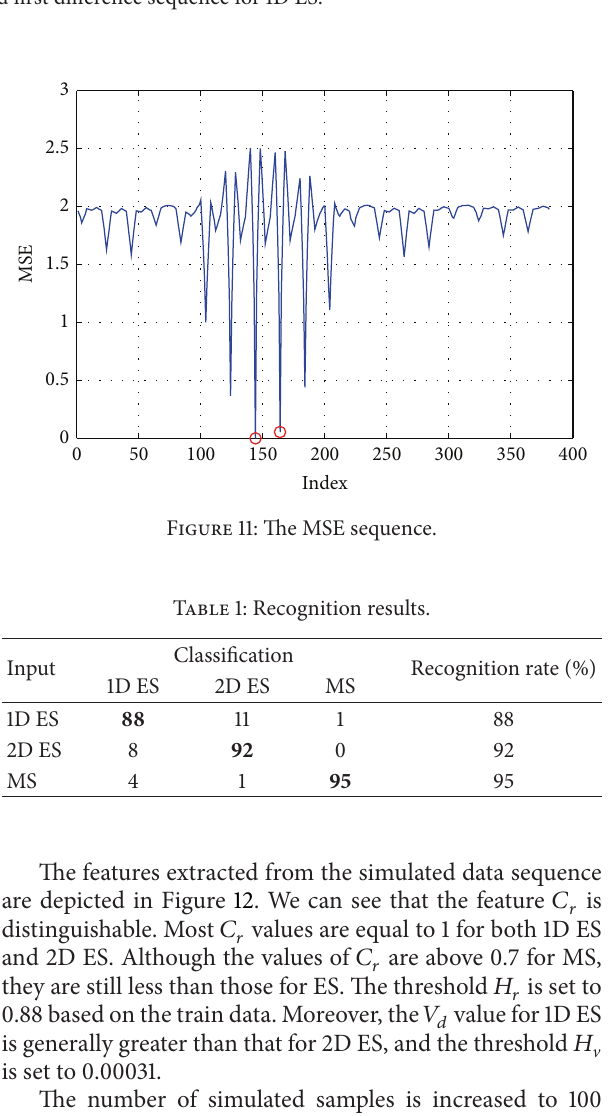
Figure 10: An extracted PA sequence and first difference sequence for 1D ES.